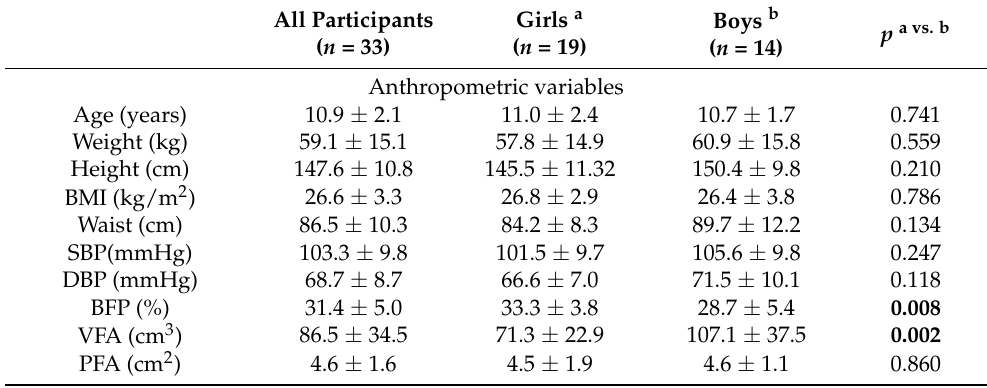
Table 1. Demographic, anthropometric, biochemical, and cardiovascular characteristics of the study